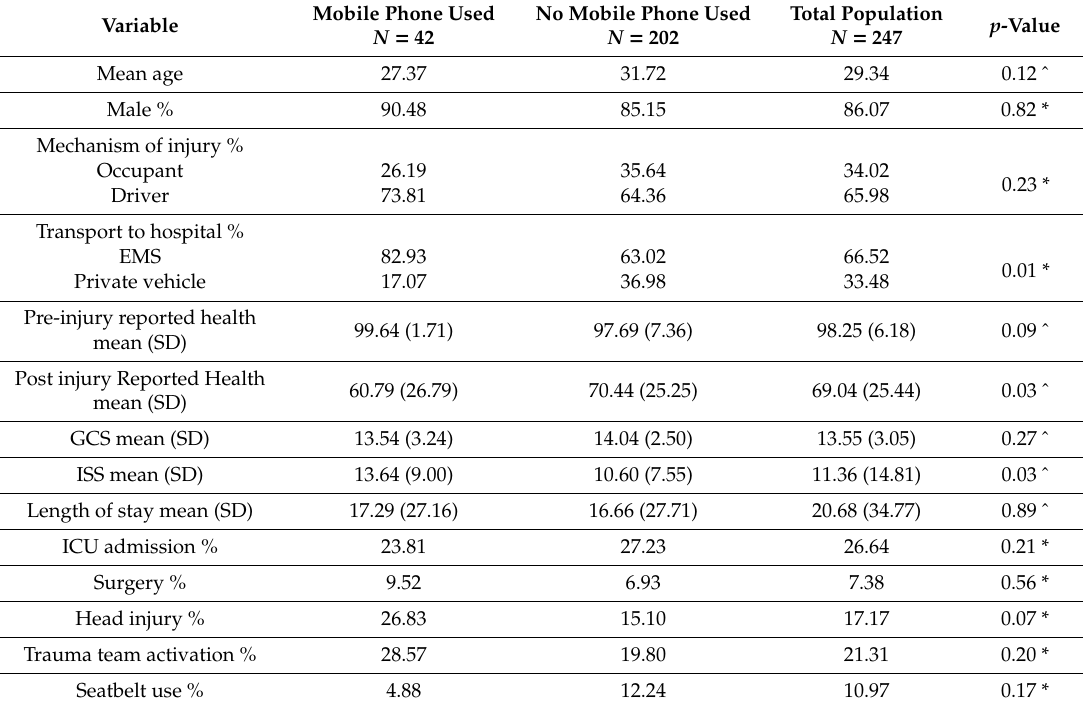
Table 1. Descriptive characteristics of cases admitted at King Abdulaziz Medical City,